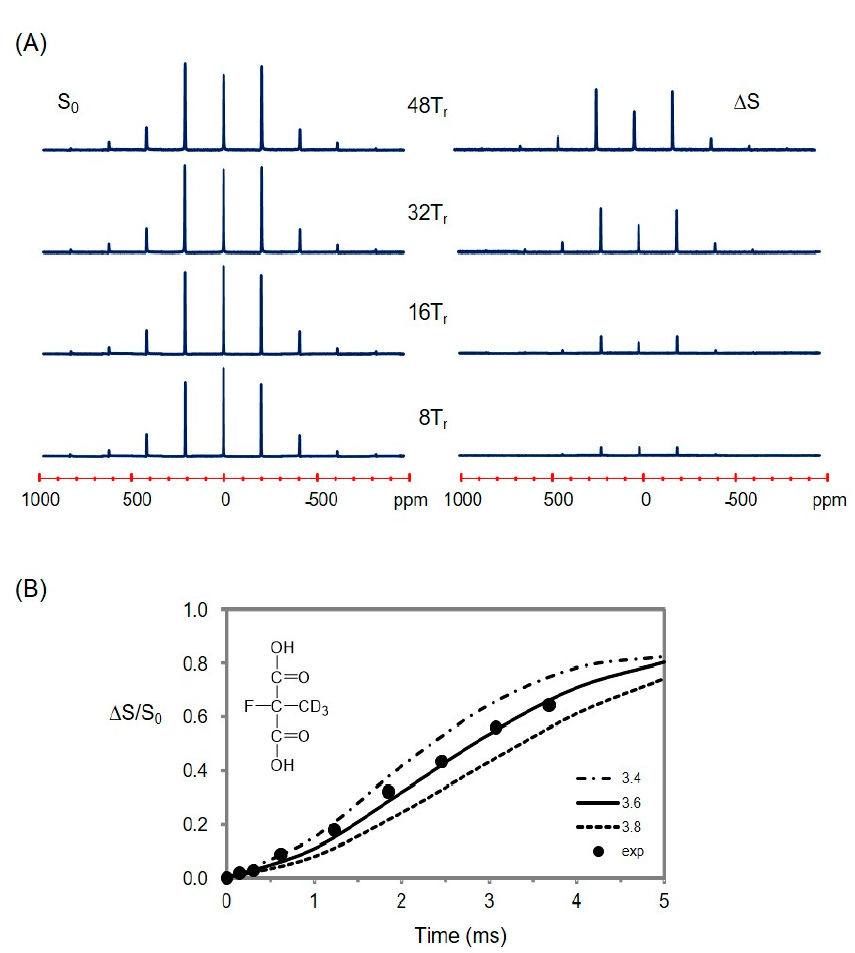
Figure 4. ( A ) The 2 H{ 19 F} REDOR spectra ( S 0 and ∆ S ) of 2-fluoro-2-methyl-d 3 -malonic acid ([2-F,2-Me-d 3 ]MA) with the dephasing times marked on the corresponding spectra; ( B ) 2 H{ 19 F} REDOR curves ( ∆ S / S 0 ), where the experimental dephasing ( • ) is consistent with the SIMPSON calculation for a single distance of 3.6 ( ± 0.2) Å. The NMR spectra were acquired at ambient temperature.